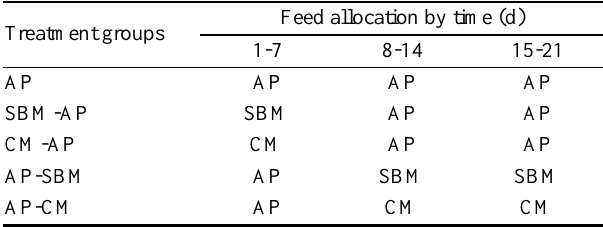
Table 1. Feeding regimes adopted in the main experiment Treatment